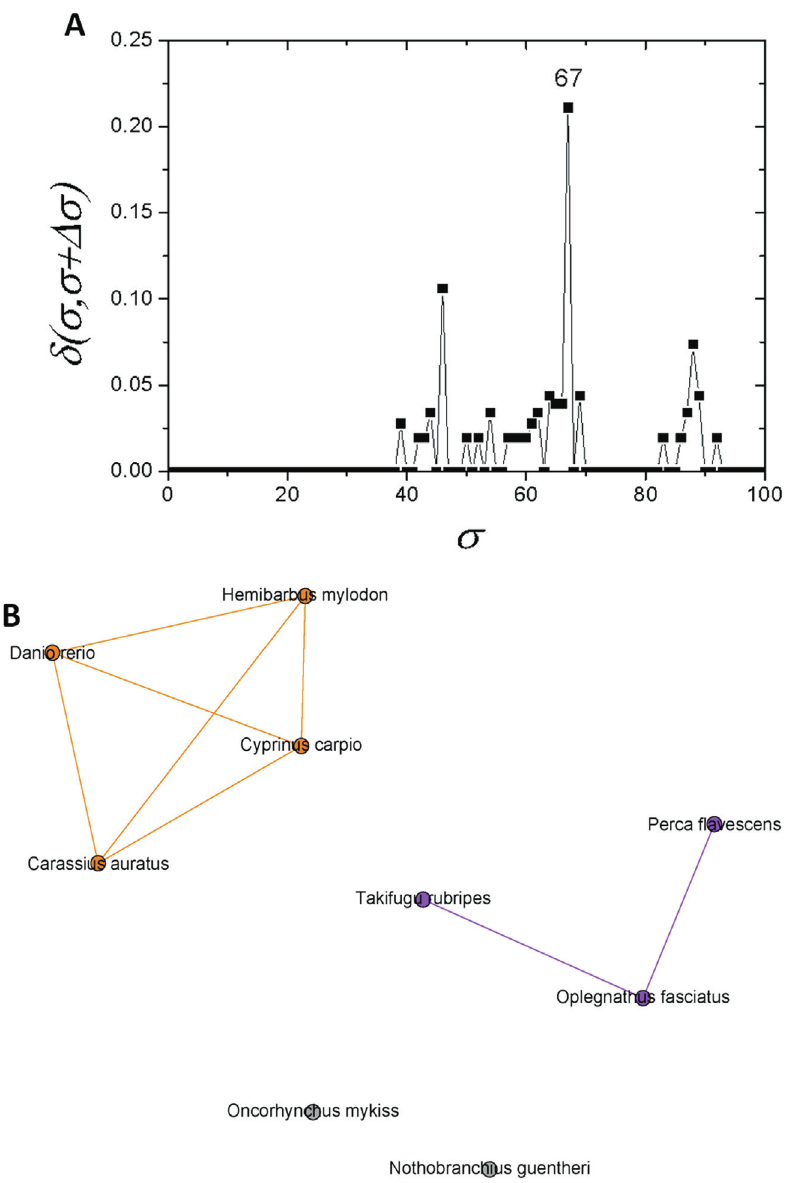
Figure 6 - Complex networks analysis. (A) Graph showing the (cid:5) -distance between networks formed by the apo E sequences from fishes with maximum (cid:5) values at (cid:3) = 67. (B) Network representation of apo E fish sequences at (cid:3) cst =67%